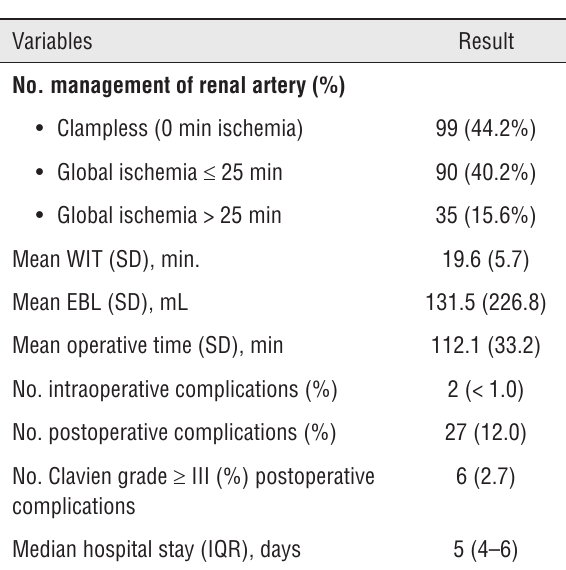
Table 3 - Perioperative